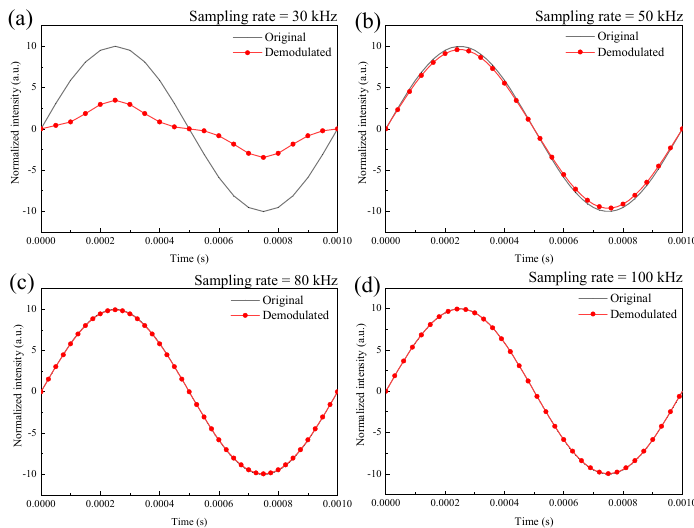
Figure 4. Simulation of the demodulated signals at sampling rates of 30 kHz ( a ), 50 kHz ( b ), 80 kHz ( c ), 100 kHz ( d ).